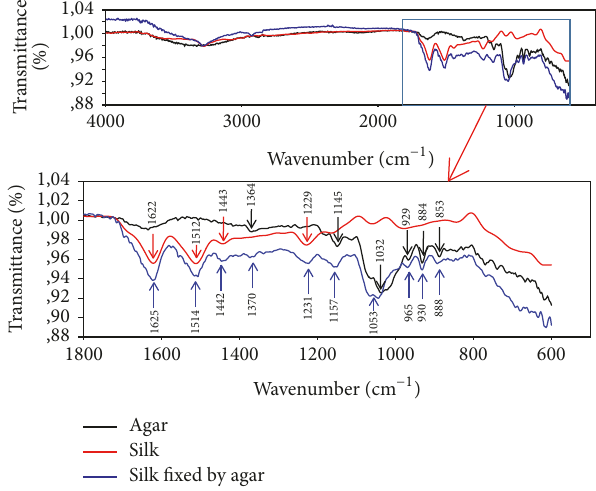
Figure 3: FT-IR spectra of 3 scaffolds: (a) in frequency range of 400–4000 cm −1 and open box; (b) in frequency range of 600–1800cm −1 . Red, black, and blue arrows showed main peaks of S, A, and SA scaffolds,